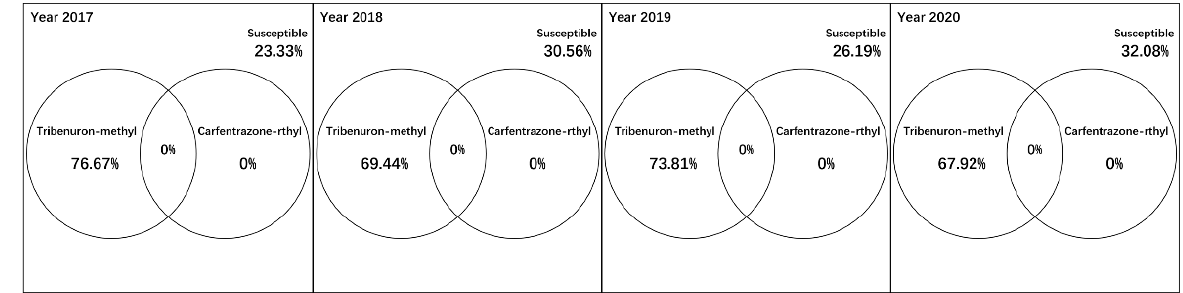
Figure 5. Proportion of cleavers seeds characterized as resistant (>20% survival) or having low resistance (2% to 19% survival) to tribenuron-methyl and a protoporphyrinogen oxidase inhibited herbicide (carfentrazone-rthyl), and the proportion of seeds that were completely susceptible (<2% survival) to both herbicides from 2017, 2018, 2019 and 2020.